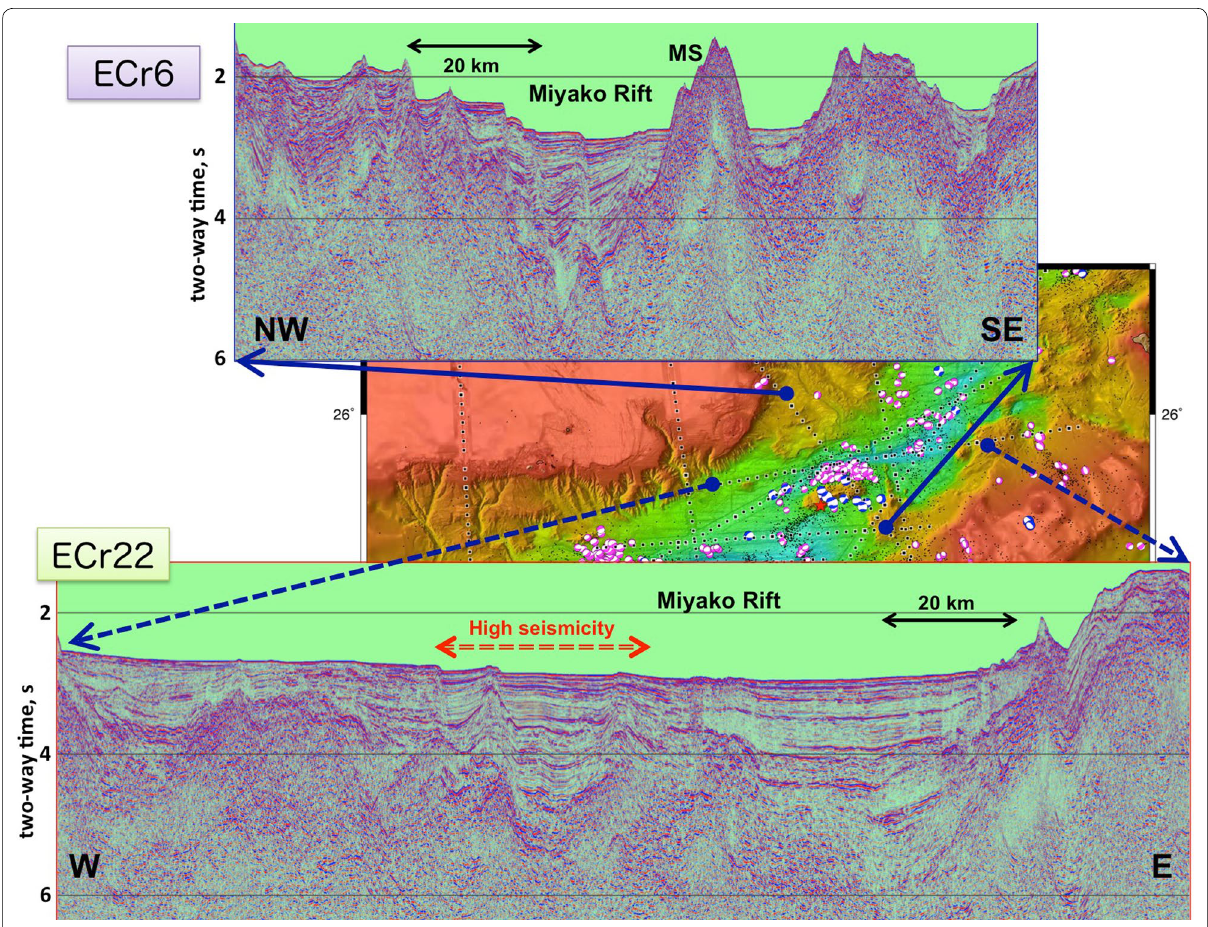
Fig. 19 MCS profiles (time sections) for ECr6 and ECr22 near the active seismic area around Miyako Seamount. Black dots show epicenters with focal depths 30 km determined by the JMA (1923–2018, February) in the bathymetric map. Pink focal mechanisms are from the F-net ≤ CMT Catalog by NIED (1997–2018, February), and blue are from the GCMT Catalog (1976–2018, February). Black squares and a red asterisk in the topographic maps (center) are positions of the OBSs and the epicenter of the 1938 M 7.2 Miyako-jima–Hokusei-oki Earthquake,